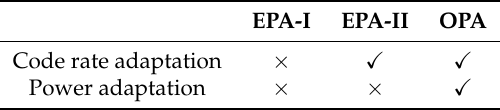
Table 2. Overview of three power allocation